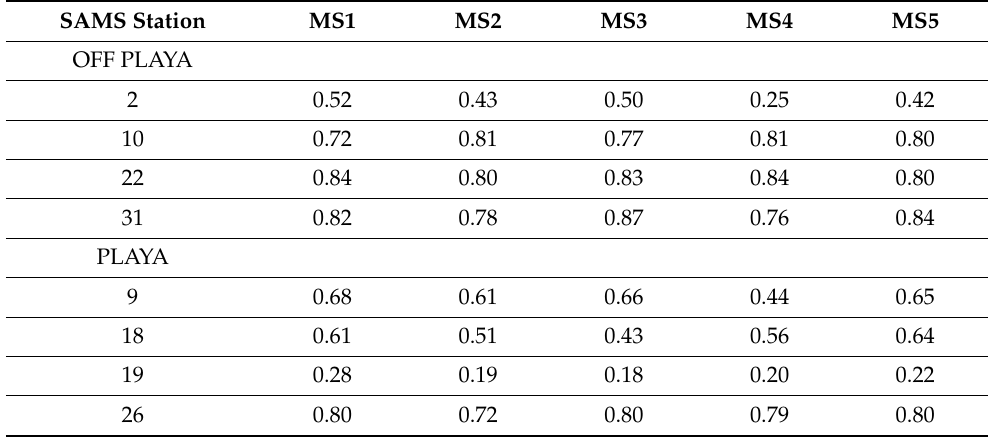
Table 9. Aggregate 10 m AGL u-wind component correlation-coefficient R values for each model setup.